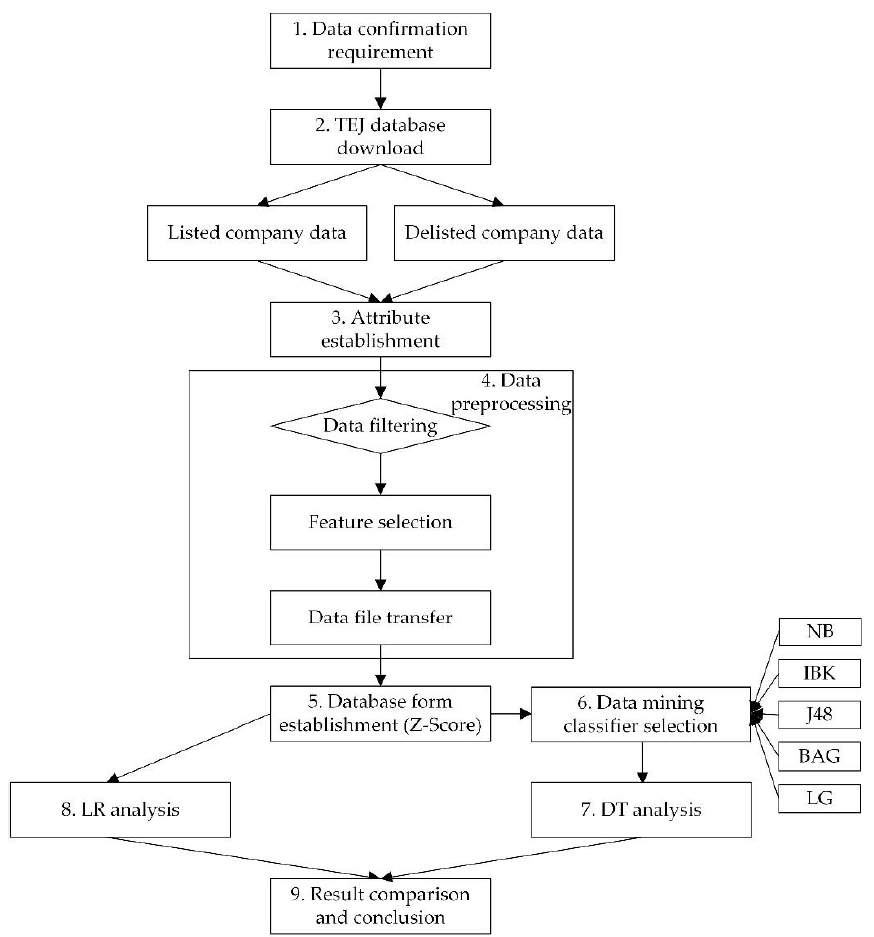
Figure 1. Research framework of the proposed hybrid model step by